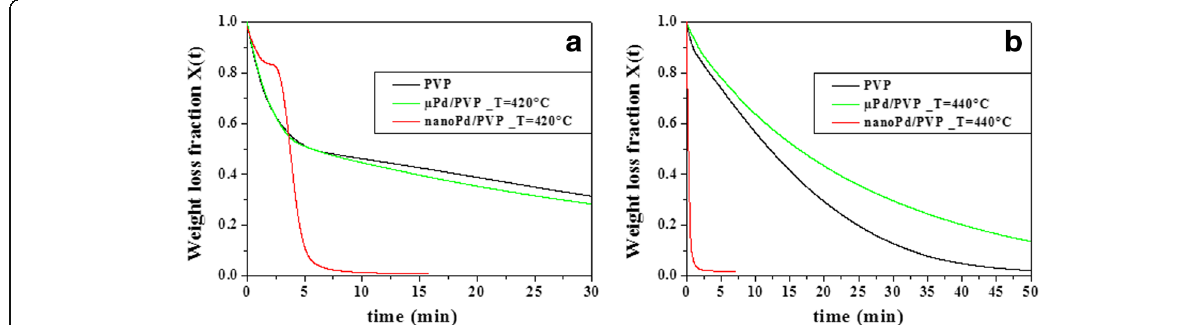
Fig. 6 Isothermal weight loss ratio as a function of the time during the combustion of pure PVP (black curves), μ -Pd/PVP (green curves), and nano-Pd/PVP (red curves) at 420 °C ( a ) and 440 °C ( b